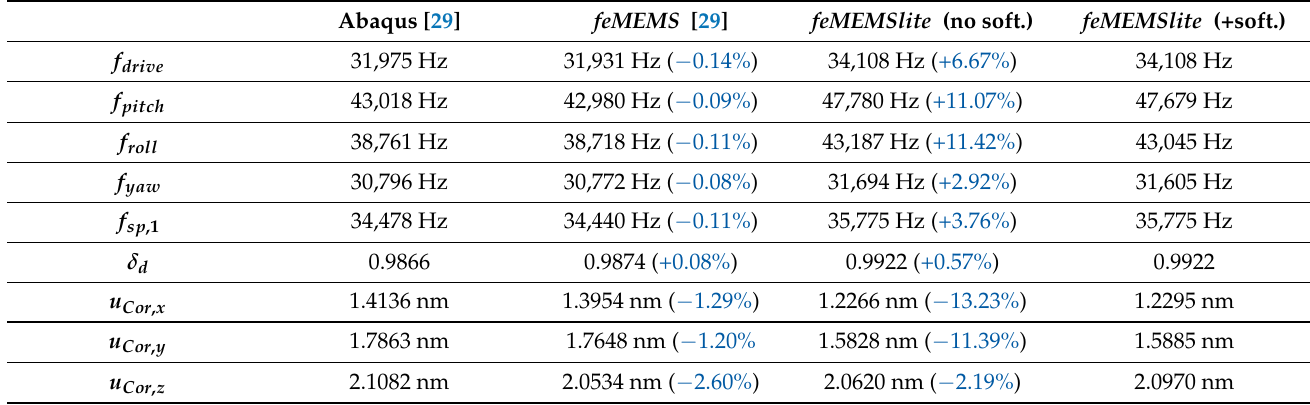
Table 2. Simulation results obtained using Abaqus (HEX20), feMEMS , and feMEMSlite . Data are partially taken from